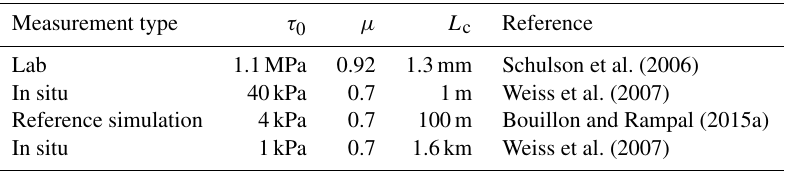
Table 1. Cohesion values, internal friction coefficient from measured Mohr–Coulomb failure envelopes. Also given are approximate defect sizes deduced from these envelopes, using the scaling law (13). These defect sizes, or sizes of stress concentrators, are only meant to give an idea of the relative sizes compared to those corresponding to the second cohesion value which is approximated to be around 1m which is of the same order as the ice thickness. The first defect size is of the same order as the grain size – the grains measured in the sample were columns of diameter 3.9mm and length 1cm. For some additional context, we also give the value used in the reference simulation of Bouillon and Rampal (2015a). This large-scale cohesion is in contrast to our small-scale cohesion ( L c ∼ 1cm), which we use to determine whether single ice floes will fracture due to wave